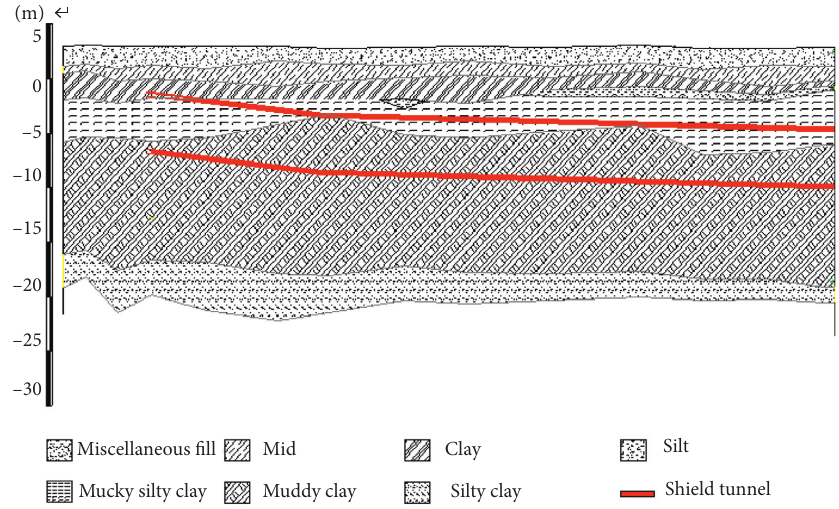
Figure 17: Geologic